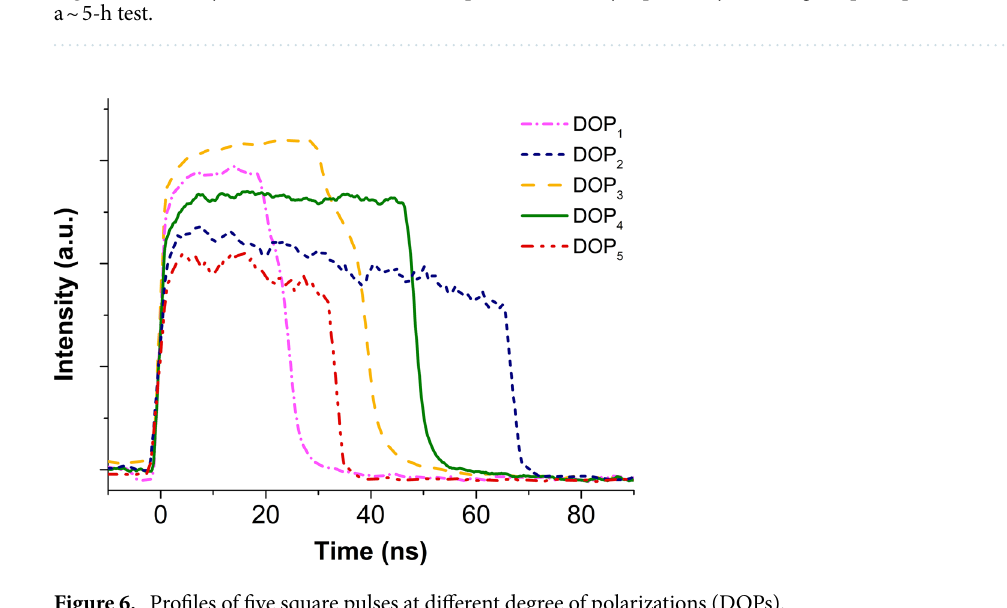
Figure 6. Profiles of five square pulses at different degree of polarizations (DOPs).